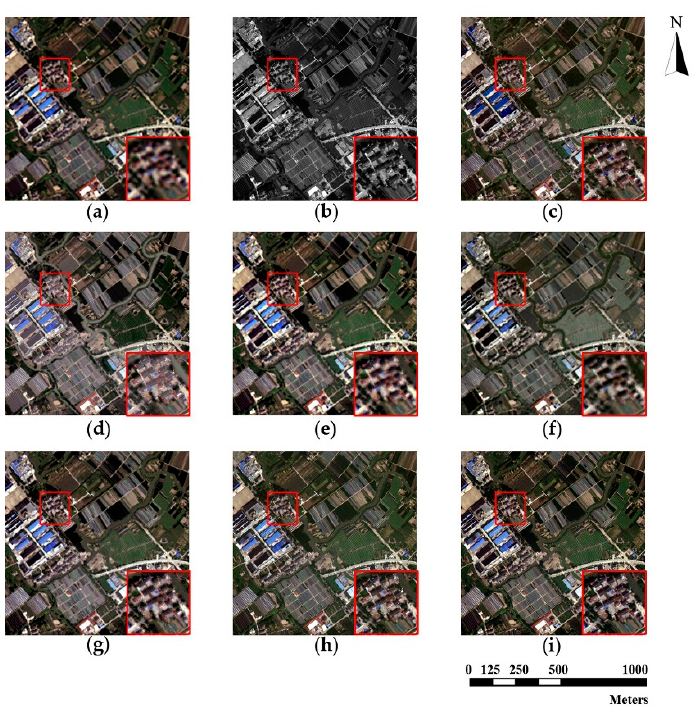
Figure 5. Triplesat original images and fusion results of different methods. ( a ) MS; ( b ) PAN; ( c ) GS; ( d ) AIHS; ( e ) WT-SR; ( f ) WT-IHS; ( g ) CT-ICA; ( h ) CSI; ( i ) proposed.